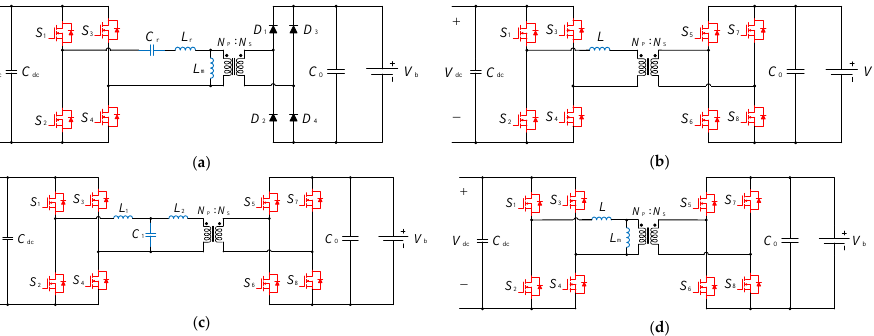
Figure 9. Isolated DC – DC converters as the EV-interfaced converter: ( a ) Full-bridge 3-level LLC resonant converter, ( b ) dual-active bridge (DAB) converter, ( c ) dual-active bridge (DAB) LCL resonant converter, and ( d ) phase-shifted full-bridge (PSFB) converter. Table 3. Non-isolated and isolated DC – DC EV-interfaced topologies Type Ref. Figure Topology